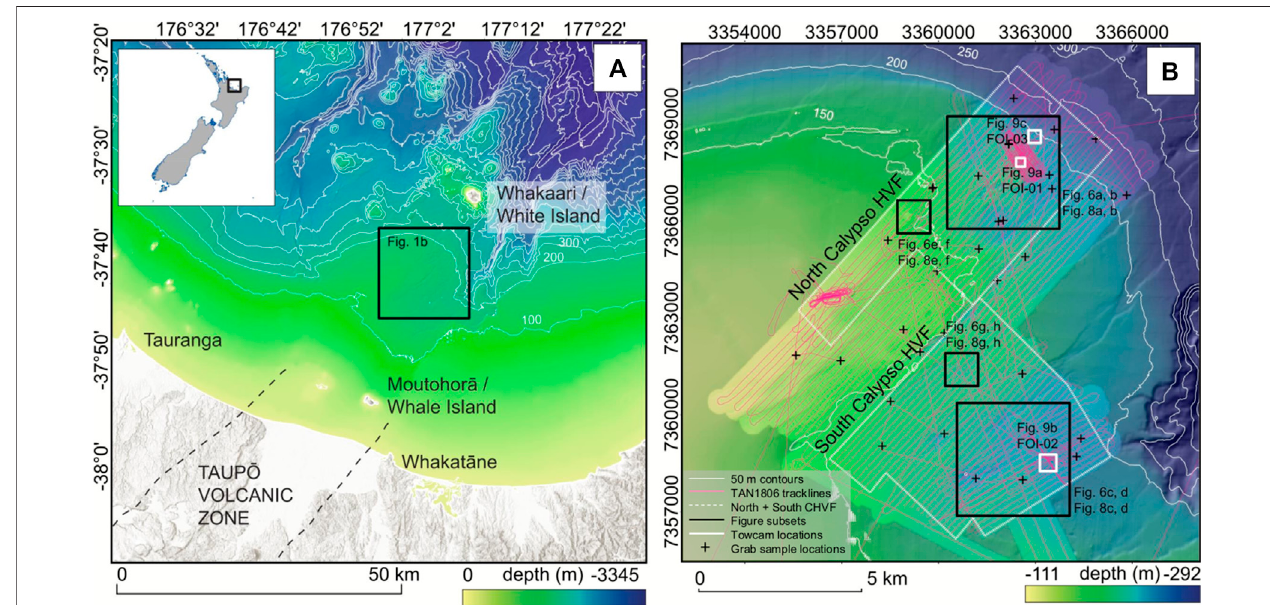
FIGURE 1 | (A) Bay of Plenty, Aotearoa/New Zealand (inset map) bathymetry, the offshore Taup ō Volcanic Zone (TVZ). The Calypso HVF (black box) sits between Whakaari/WhiteIsland andMoutohor ā /WhaleIsland(black dashed lines:TVZ approximate boundaries; whitelines:100 mcontours;). (B) CalypsoHVF5 mbathymetry, collectedduring TAN1806, draped over regionalbathymetry (white lines:50 m contours; pinklines: vessel track; whitedashed boxes: clipped North and South Calypso HVF regions; white boxes: towed camera locations; black crosses: sediment grab locations).